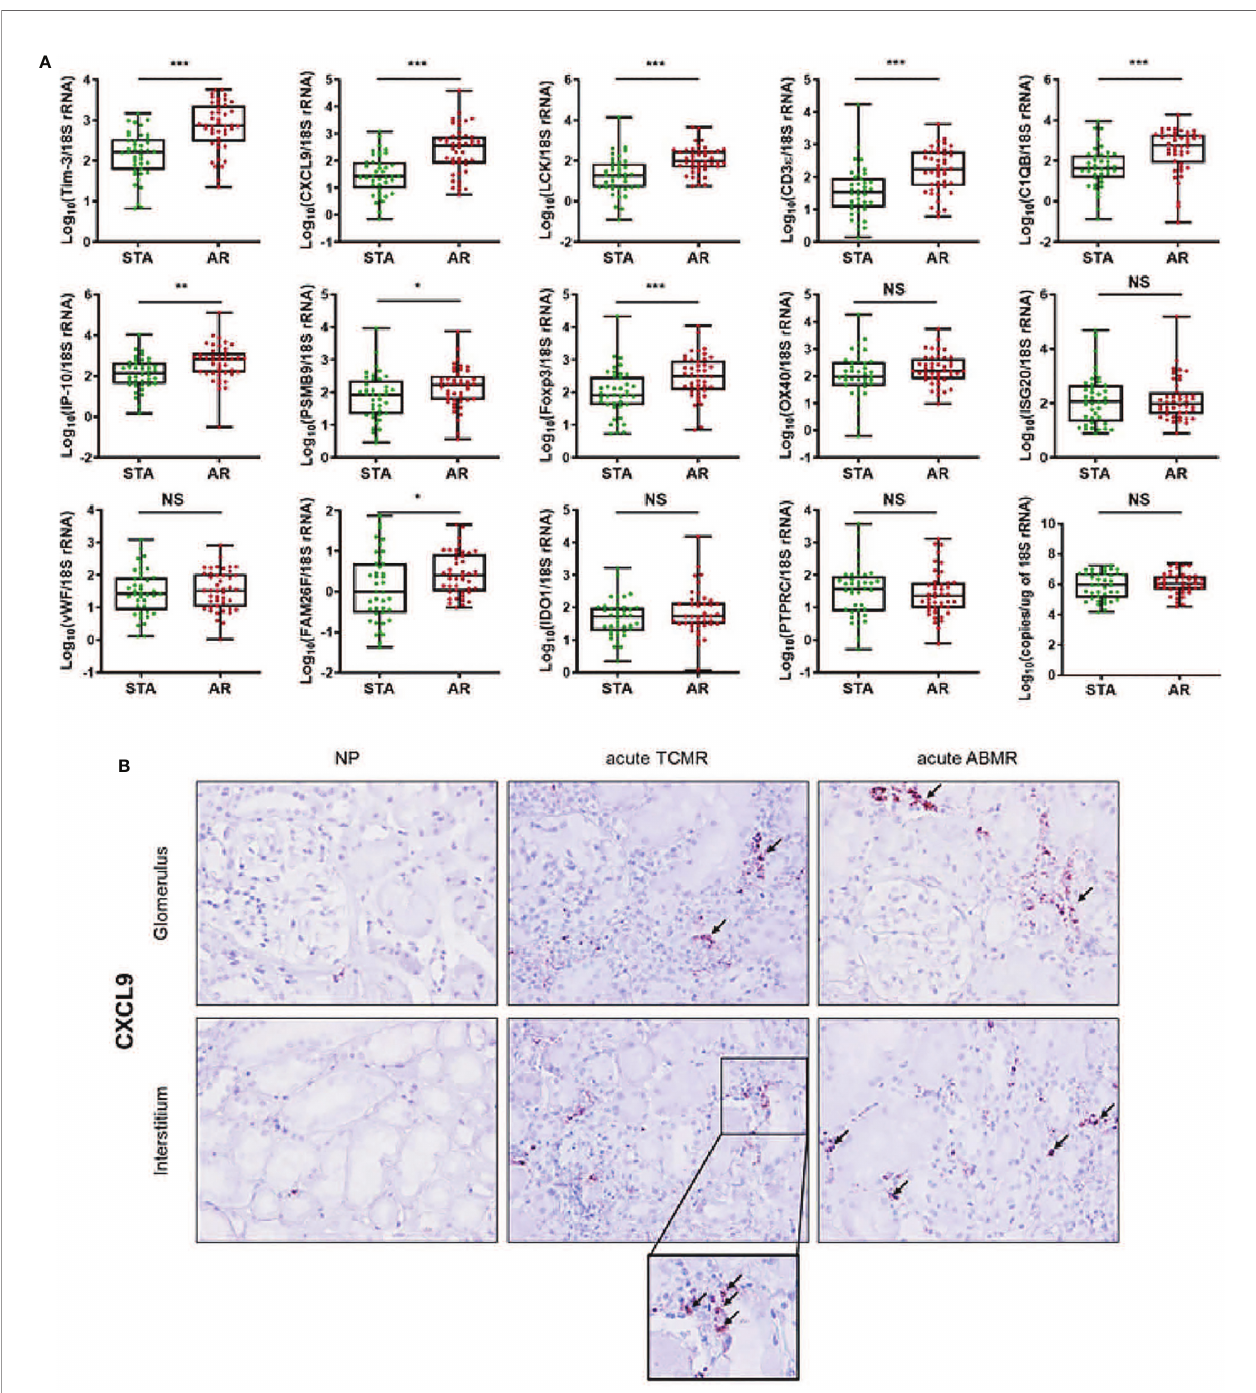
FIGURE 2 | The expression levels of each mRNA between STA (n=45) and AR (n=58) were analyzed using absolute quantitative qPCR without pre-ampli fi cation. Each mRNA level was log10-transformed after each mRNA copy number was normalized with 18S rRNA copies (x10-6) in the QC-passed samples (STA, n=40; AR, n=44). (A) The levels of CXCL9, IP-10, C1QB, PSMB9, LCK, CD3e, Foxp3, FAM26F, and Tim-3 mRNAs were signi fi cantly elevated in AR compared to STA, and for OX40, ISG20, vWF, IDO1, and PTPRC mRNAs, there was no difference. In the 18s rRNA used as an endogenous control, there was no difference between AR and STA. P values by the non-parametric Mann-Whitney test were expressed as the mean ± SE. NS: not signi fi cant, *P < 0.05, **P < 0.01 and ***P < 0.001 versus STA. Although LCK, Foxp3, and FAM26F mRNAs were statistically signi fi cant, these mRNAs were not detected in more than 10% of the QC-passed samples. Therefore, we excluded these mRNAs for further analysis. (B) CXCL9 mRNA expression in kidney biopsy tissues of NP, acute TCMR and acute ABMR groups was examined by ISH (original magni fi cation x400). CXCL9 was distinctly expressed in the damaged tubules in kidney allografts of acute TCMR and predominantly in the peritubular capillary area in ABMR groups (black arrows). Scale bars: 50 m